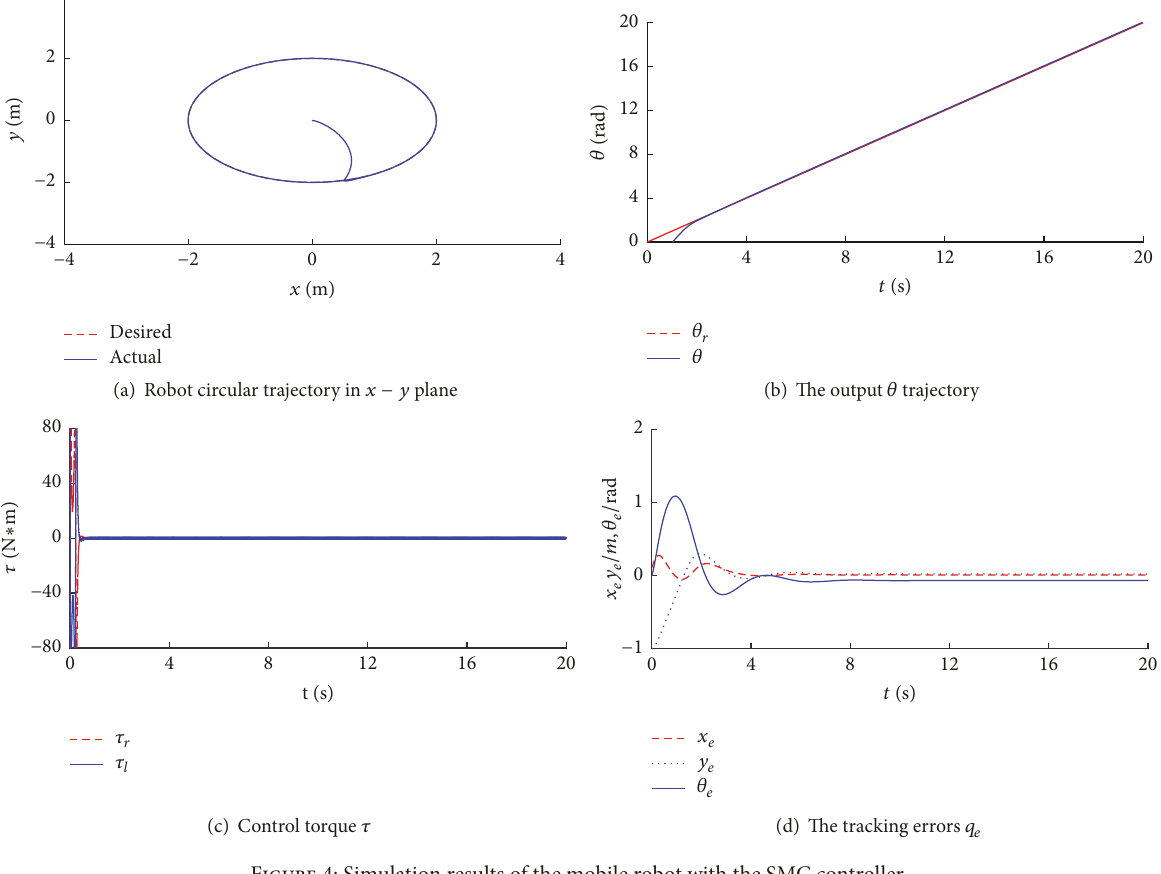
Figure 4: Simulation results of the mobile robot with the SMC controller.